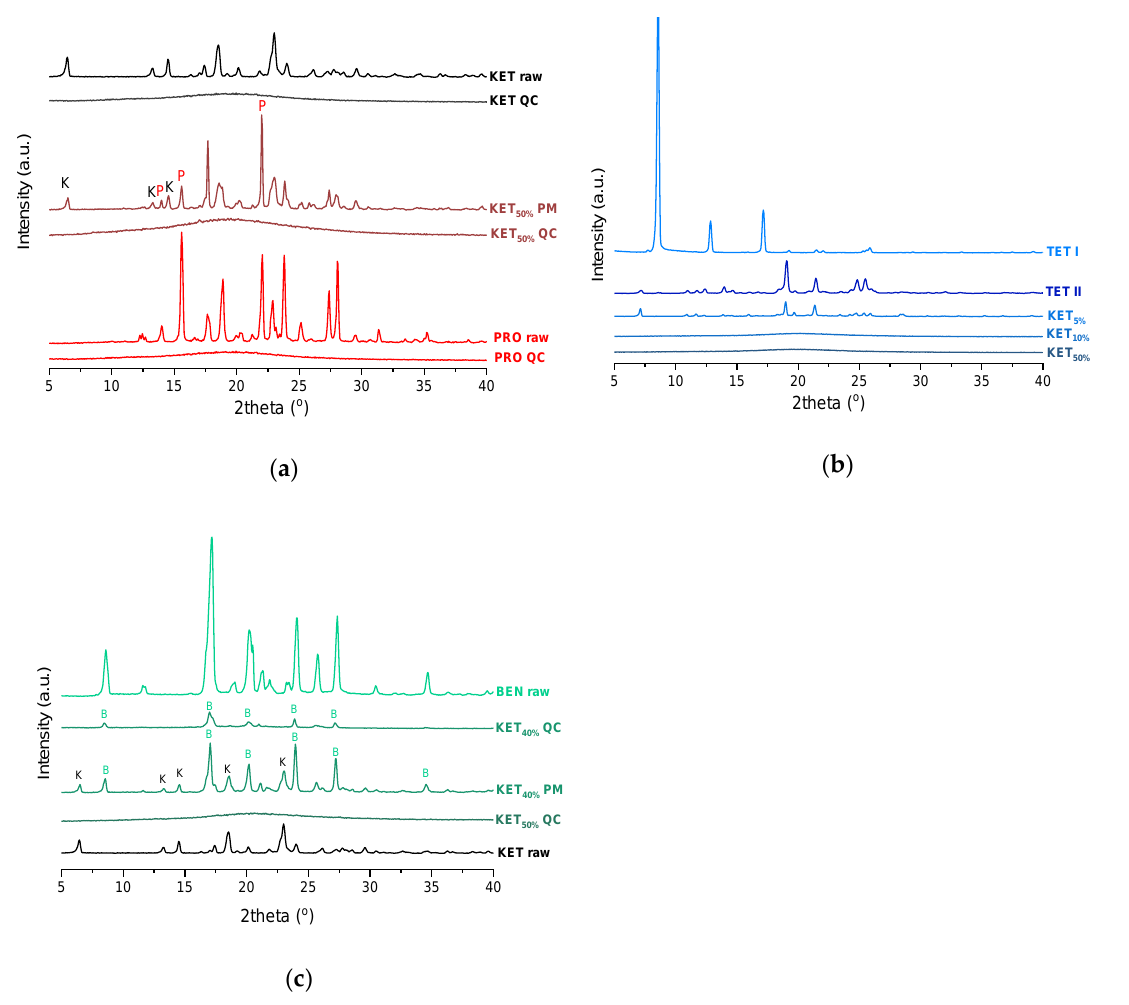
Figure 3. PXRD of: ( a ) KET, PRO and equimolar KET-PRO mixtures; ( b ) KET, TET and KET-TET mixtures; ( c ) KET, BEN and KET-BEN mixtures. QC-quench cooled, PM-physical mixture, raw-as supplied, TET I-TET polymorphic form I, TET II-TET polymorphic form II. The subscript indicates the KET content in mole%.